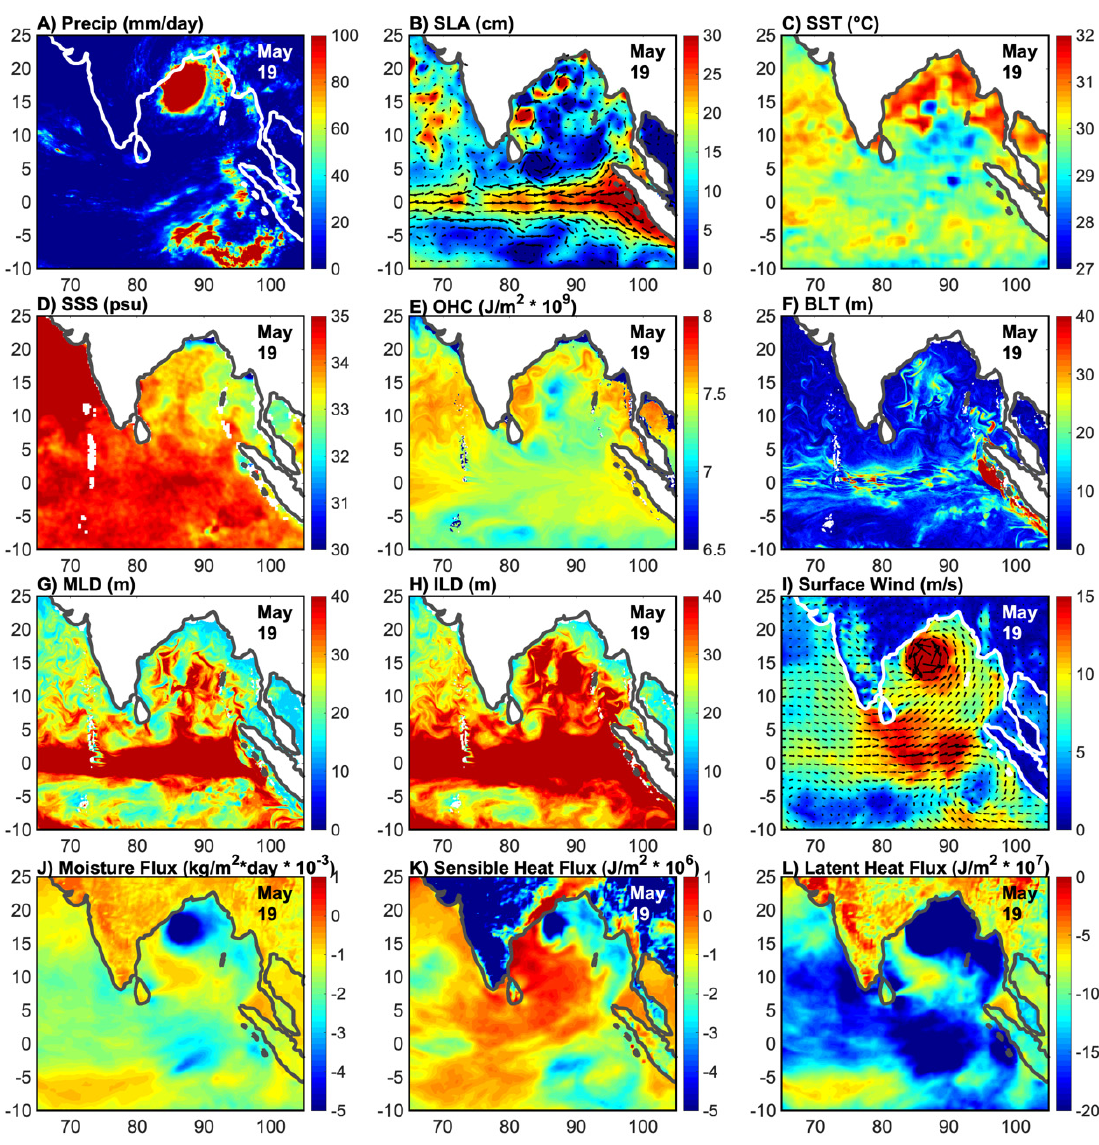
Figure 3. Multiparameter analysis of the Bay of Bengal on May 19, 2020 at the peak of the storm in ( a ) Global Precipitation Measurement (GPM) precipitation rate (mm/day); ( b ) Copernicus Marine and Environment Monitoring Service (CMEMS) sea level anomalies (SLAs) (cm) overlaid with geostrophic currents (cm/s); ( c ) Nucleus for the European Modeling of the Ocean (NEMO) sea surface temperature (SST) data (°C); ( d ) NEMO sea surface salinity (SSS) data (psu); ( e ) 0–30 m ocean heat content (OHC; J/m 2 * 10 9 ) calculated from NEMO; ( f ) barrier layer thickness (BLT; m) calculated from NEMO; ( g ) mixed layer depth (MLD; m) calculated from NEMO; ( h ) isothermal layer depth (ILD; m) calculated from NEMO; ( i ) Cross-Calibrated Multi-Platform version 2 (CCMPv2) surface wind magnitude (m/s; shaded) and vectors; ( j ) ERA5 instantaneous moisture flux (kg/m 2 *day*10 − 3 ); ( k ) ERA5 surface sensible heat flux (J/m 2 * 10 6 ); and ( l ) ERA5 surface latent heat flux (J/m 2 * 10 7 ).